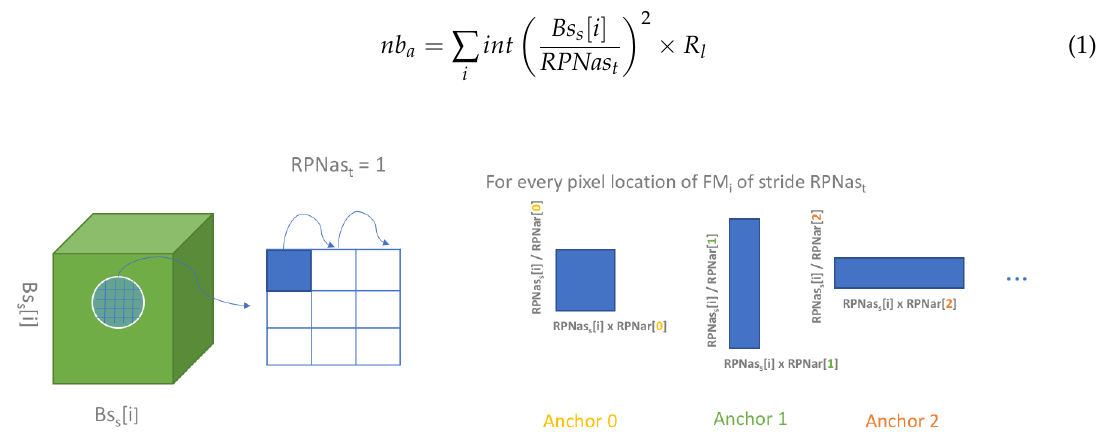
Figure 4. Anchors generation for the i th feature map FM i feeding the RPN of shape Bs s [ i ] . FM i is related to anchors of corresponding anchor scale RPNas s [ i ] on which the collection of ratios RPNar is applied to to generate R l (number of ratios) anchors at each pixel location obtained from the FM i with stride RPNas s